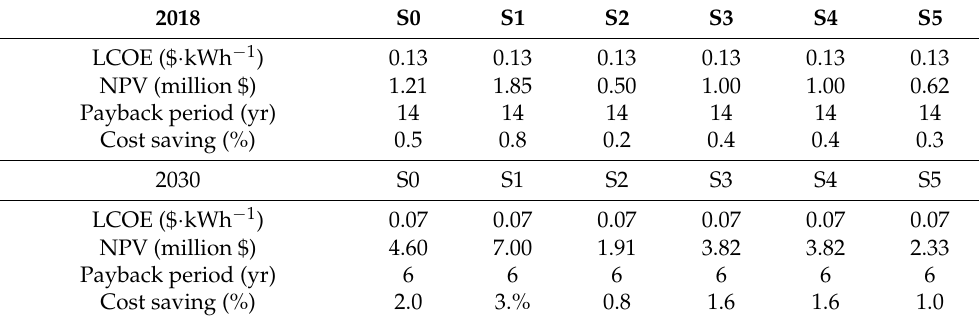
Table 7. Financial indicators of rooftop PV systems for 2018 and